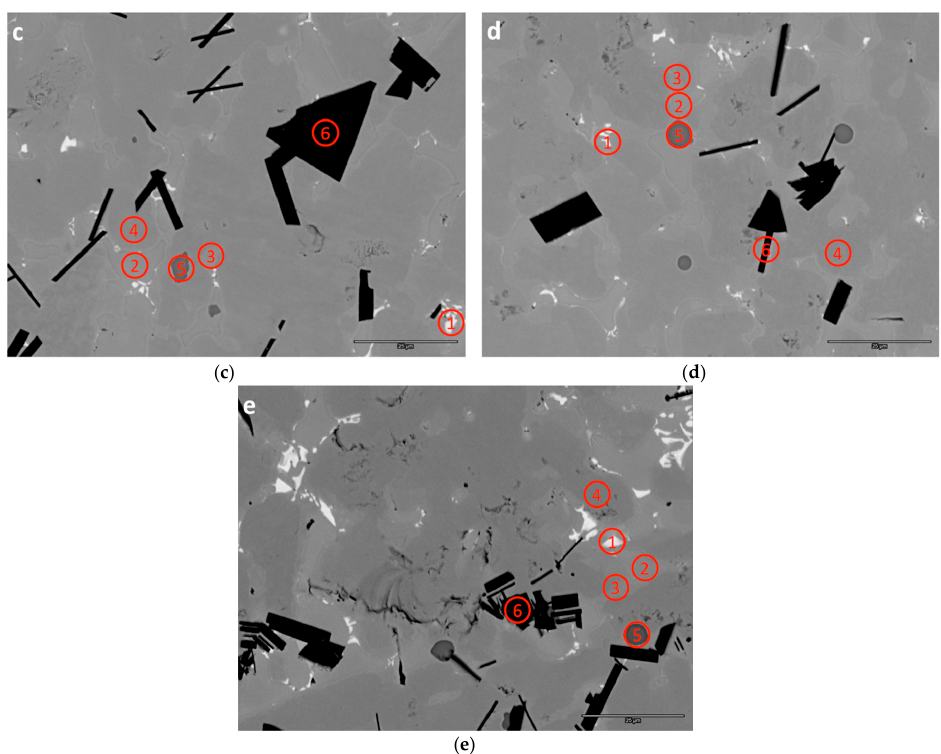
Figure 5. SEM back-scattering electron images (BEIs) of alloys ( a ) B1; ( b ) B2; ( c ) B3; ( d ) B4; and ( e ) B5. Compositions of the numbered areas were analyzed by energy dispersive spectroscopy (EDS), and the results are shown in Table 4. Areas 1 − 6 are identified as the Zr 7 Ni 10 , TiNi, C15, C14, ZrO 2 , and V 3 B 2 phases, respectively. Table 3. Summary of the EDS results. All compositions are in at%. Compositions of the main C14 and C15 phases are in bold and italic , respectively.